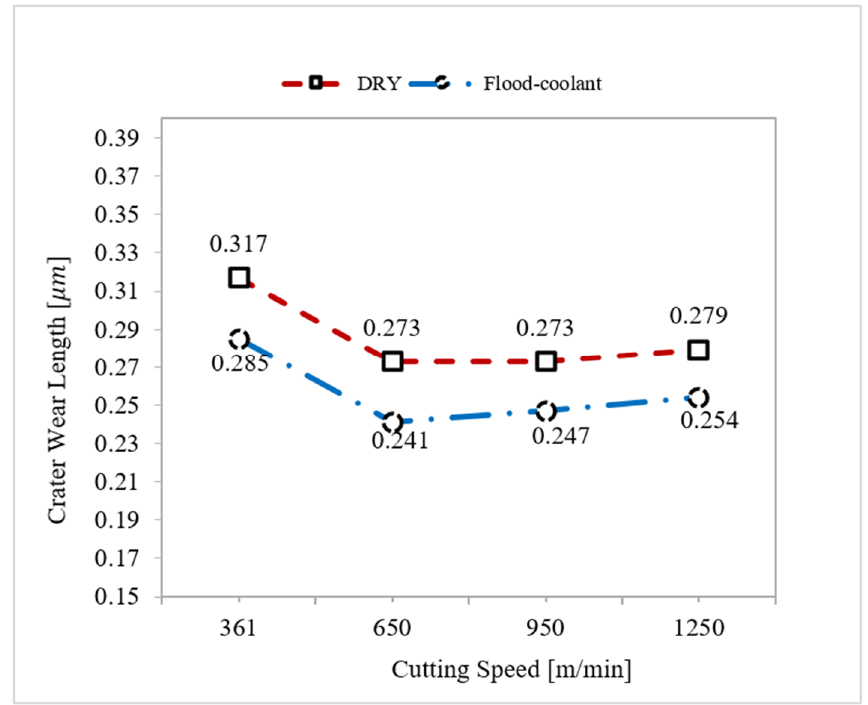
Figure 7. Variation of crater wear length with cutting speed in dry and flood-coolant modes.